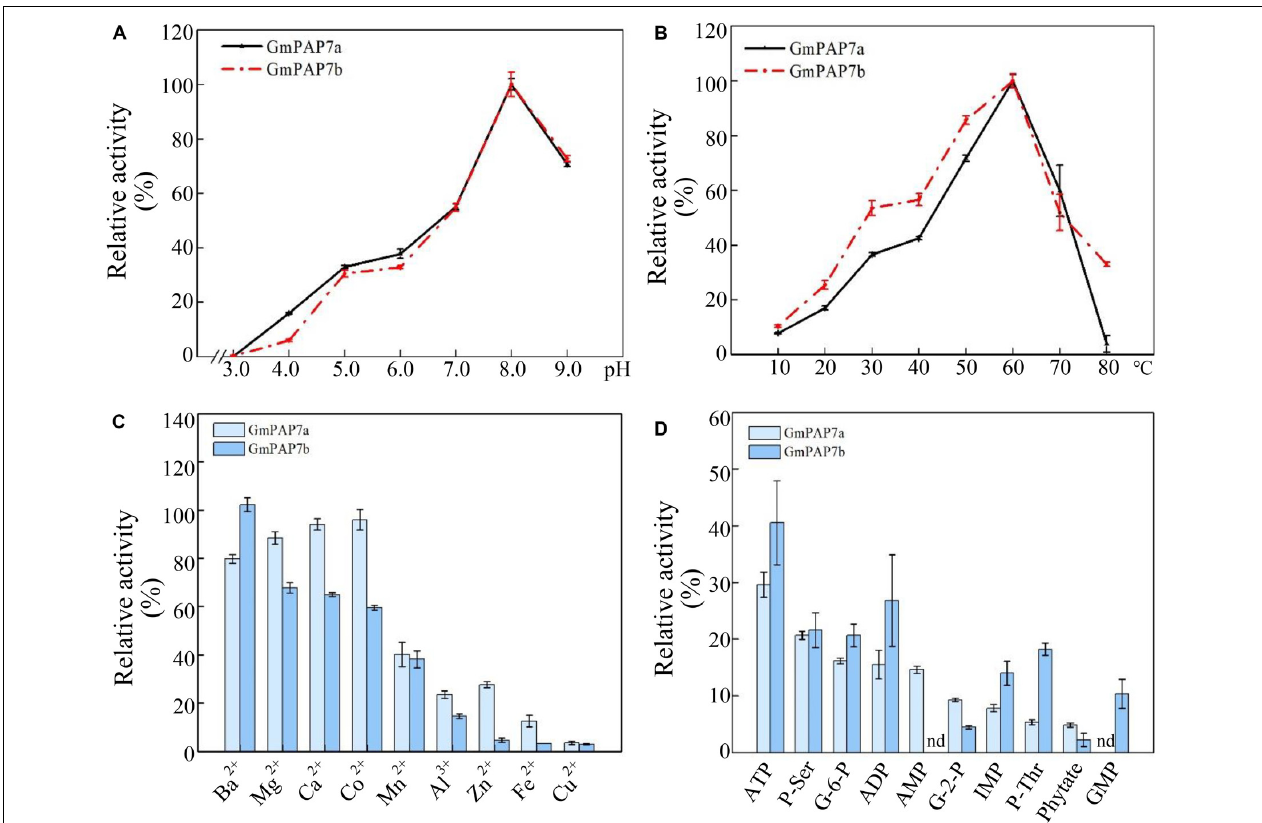
FIGURE 6 | Enzymatic properties of GmPAP7a and GmPAP7b. (A) Effects of pH on the relative activities of GmPAP7a and GmPAP7b. (B) Effects of temperature on the relative activities of GmPAP7a and GmPAP7b. (C) Effects of metal ions on the relative activities of GmPAP7a and GmPAP7b. (D) Relative activities of GmPAP7a and GmPAP7b against different substrates. The data are the means of three replicates with standard errors. nd indicates that no activity was